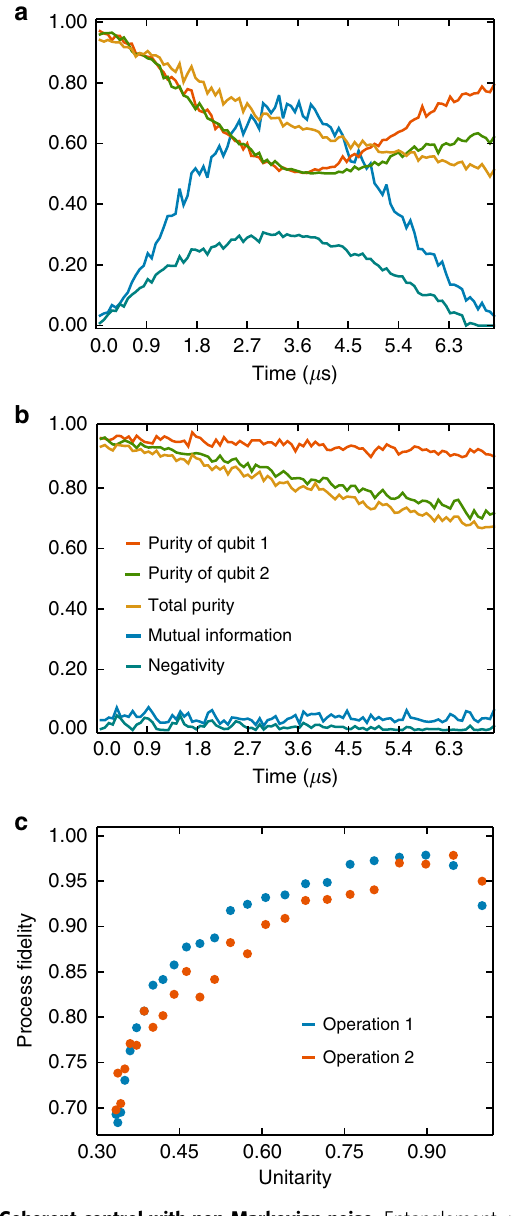
Fig. 5 Coherent control with non-Markovian noise. Entanglement, mutual information, and purities extracted from the two-qubit density matrix after being initialised in the þþj i state. a Both qubits are left idle and the natural evolution is tracked. b As a simple demonstrative application of the process tensor, we use the construction from Eq. (9) to fi nd the optimal decoupling pulse. We periodically apply this gate to qubit 1. We see greatly improved coherences and almost complete elimination of entanglement between the two qubits, without actually characterising the nature of the interaction. c We use the process tensor to implement speci fi c non-unitary gates. We plot the process fi delity as a function of the unitarity for two randomly chosen operations, according to the measure given in ref. 42